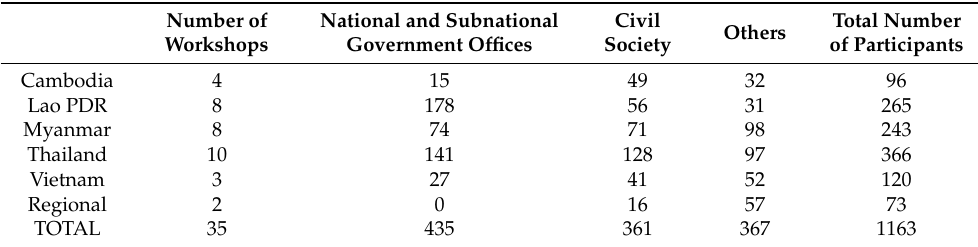
Table 2. Total number of participants in all the workshops (inception, data collection and results sharing) (for more information see Appendix A).